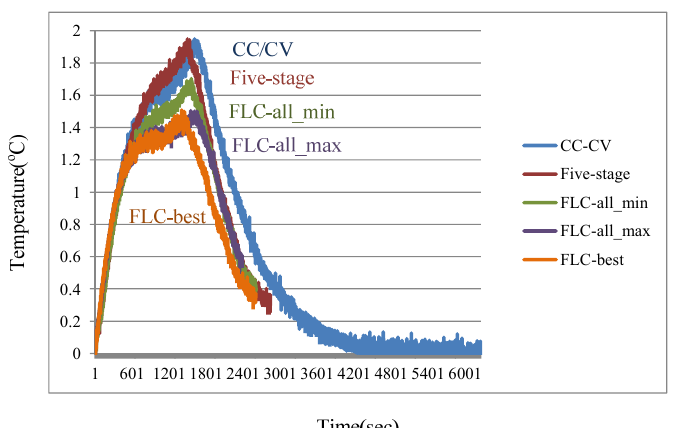
Figure 12. Temperature rise of five tested algorithms.